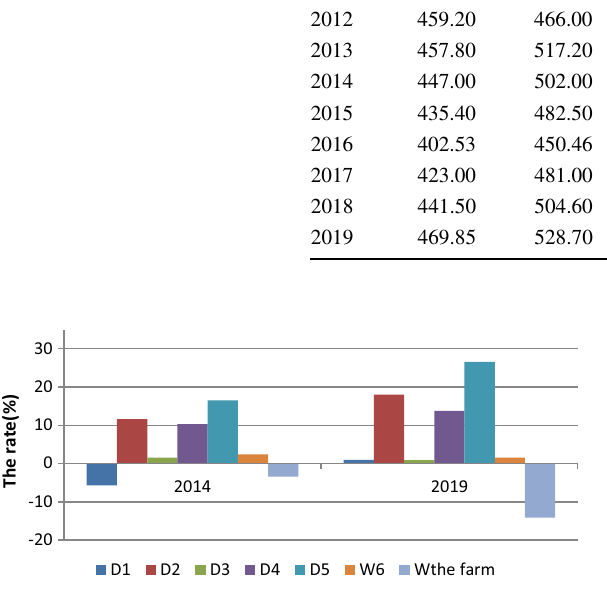
Table 5 TDS (mg/l) values of water points in the Mougheul area (2009–2019)